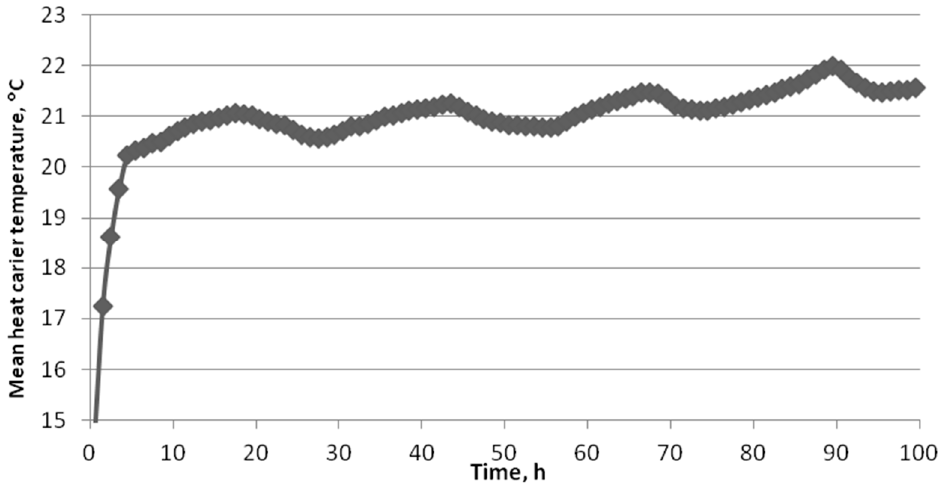
Figure 6. TRT results with the measurement data averaging every 1 h.